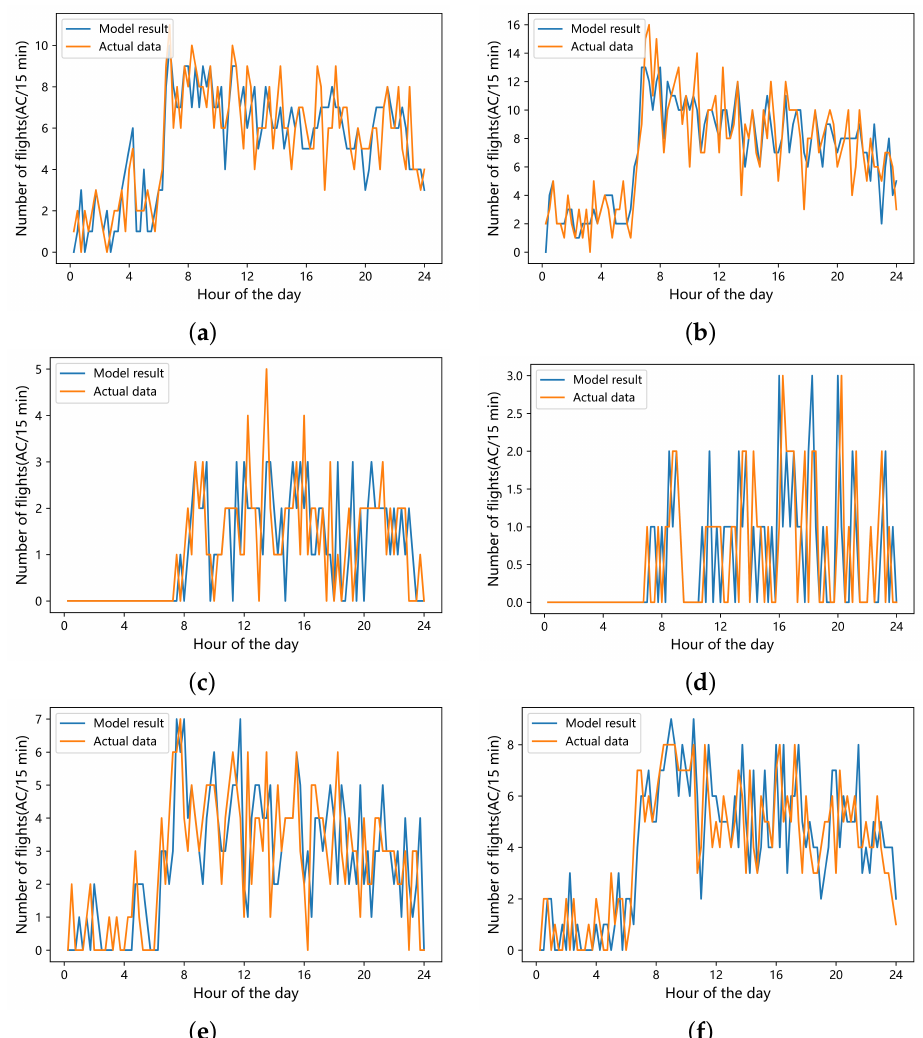
Figure 8. Hourly departure traffic at the four airports and two waypoints (LMN and YIN). ( a ) ZGSZ; ( b ) ZGGG; ( c ) VMMC; ( d ) ZGSD; ( e ) LMN; ( f )